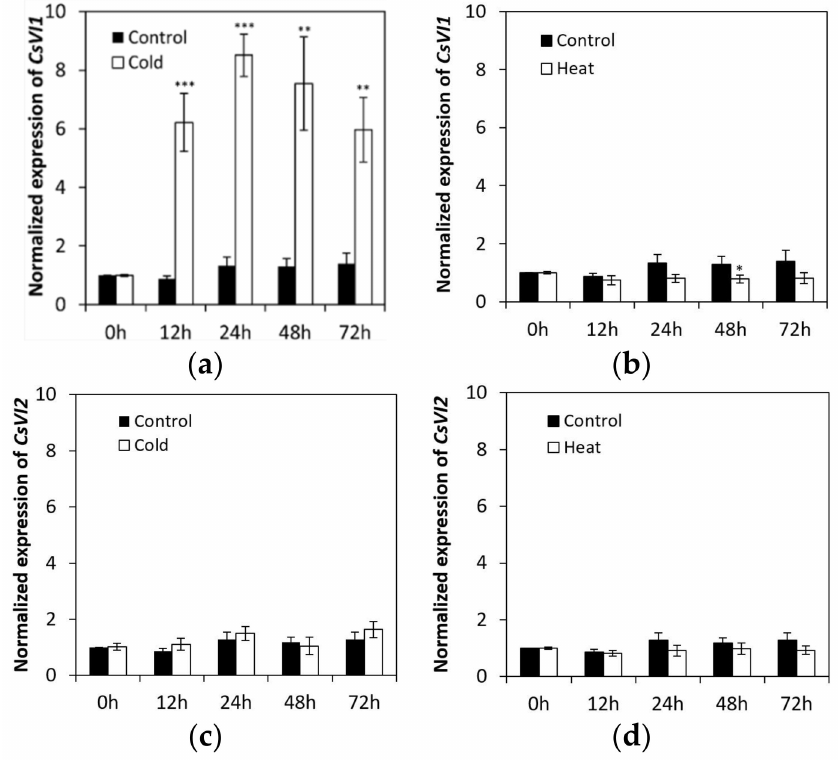
Figure 5. Effects of low temperature or heat treatments on the expression of CsVI1 ( a , b ) and CsVI2 ( c , d ) in cucumber seedling roots. Results are means of >3 biological replicates ( ± SE) each with three technical replicates. Asterisks indicate statistically significant differences (*, p -value < 0.05; **, p -value < 0.01; ***, p -value <